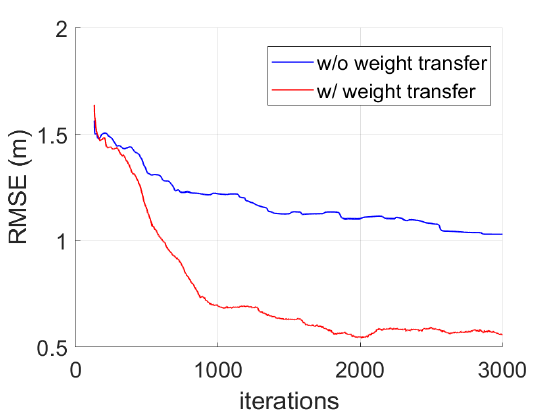
Figure 5. The root-mean-square error (RMSE) performance of map estimation with and without the weight transfer